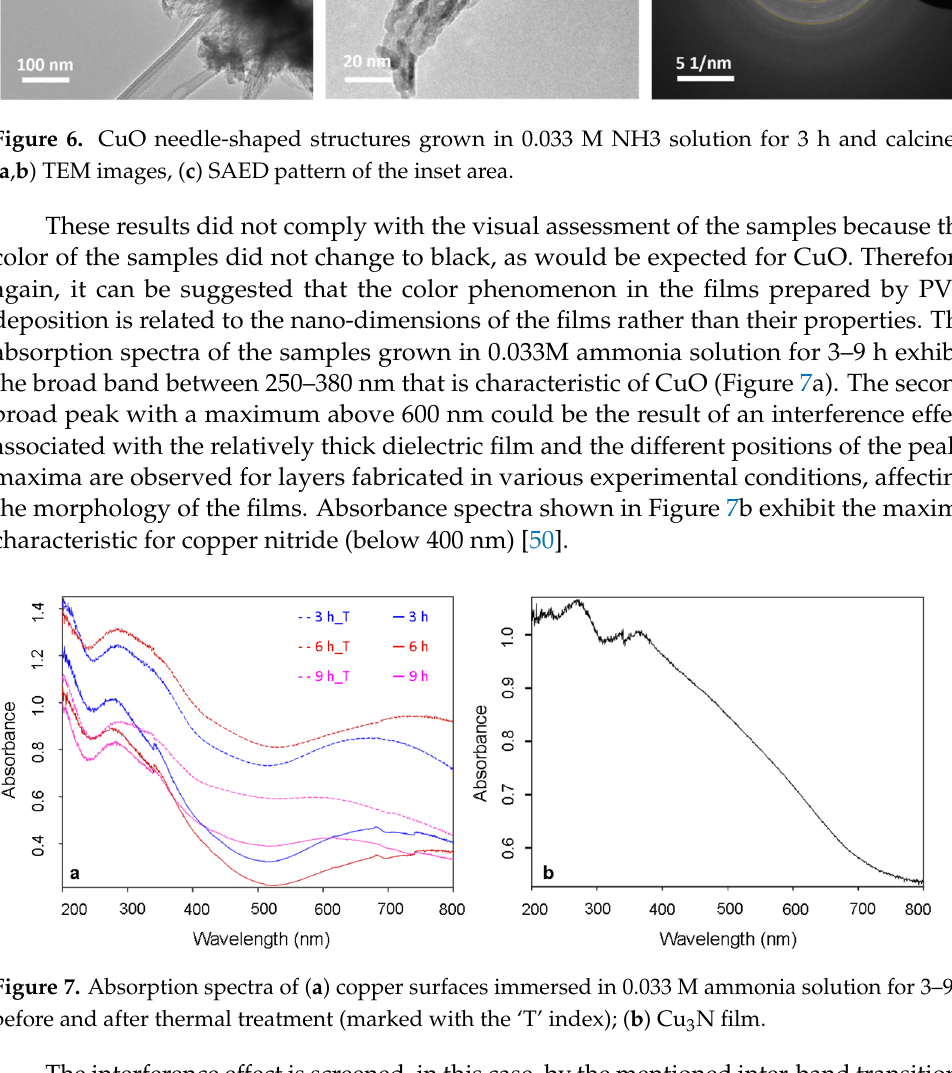
Figure 6. CuO needle-shaped structures grown in 0.033 M NH3 solution for 3 h and calcined: ( a , b ) TEM images, ( c ) SAED pattern of the inset area.